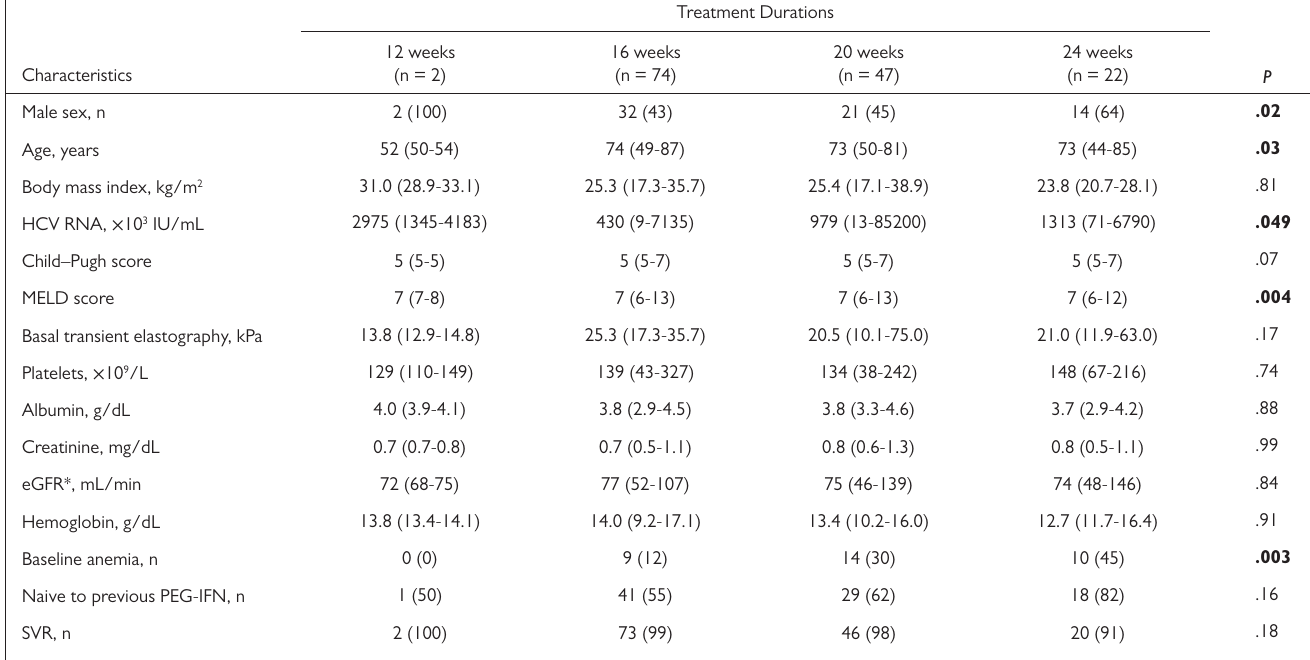
Table 4. Comparison of the Main Demographic and Clinical Features of the Patients Who Completed the Planned Treatment (n = 145), Divided According to the Single Different Treatment Durations